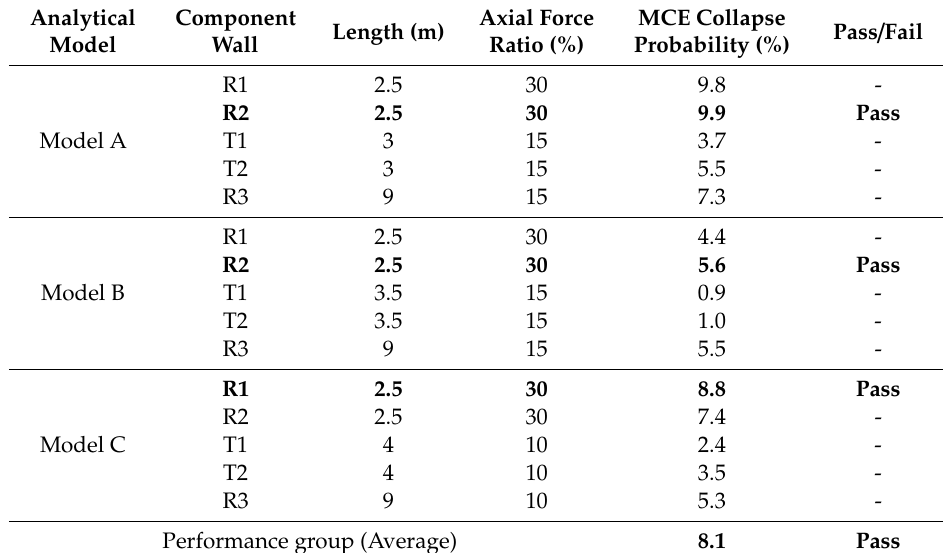
Table 10. Summary of collapse probability for analytical models designed for the shear force amplification factor =